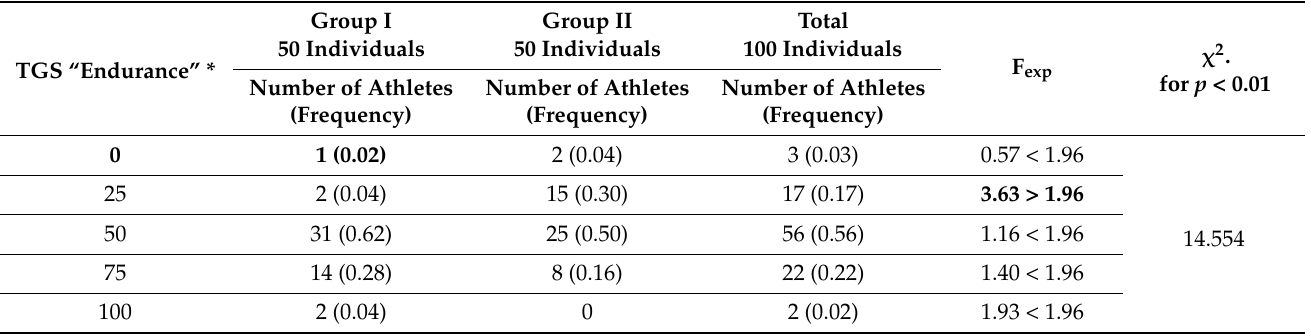
Table 5. The total genetic score of martial arts practitioners is based on NOS3 и PPARGC1A genes polymorphism ( n = 100).